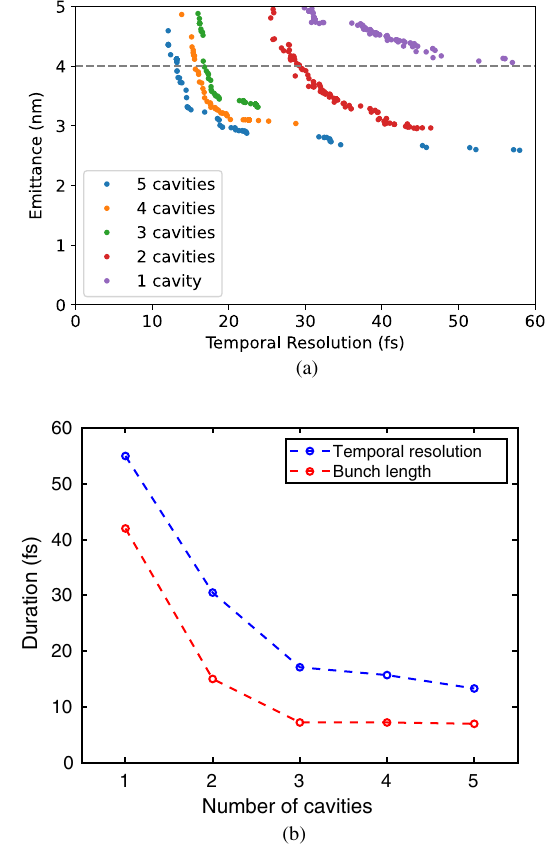
FIG. 10. (a) Trade-off between achievable temporal resolution and emittance for different numbers of SRF cavities. (b) Temporal resolution and bunch length for different numbers of SRF cavities at a constant emittance of